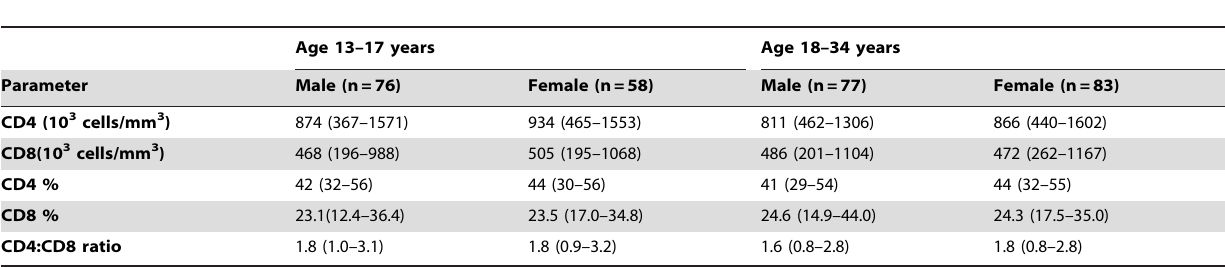
Table 5. Lymphocyte sub-sets reference ranges (median and 95 th -percentile) from a cohort (13–34 years) in rural Western